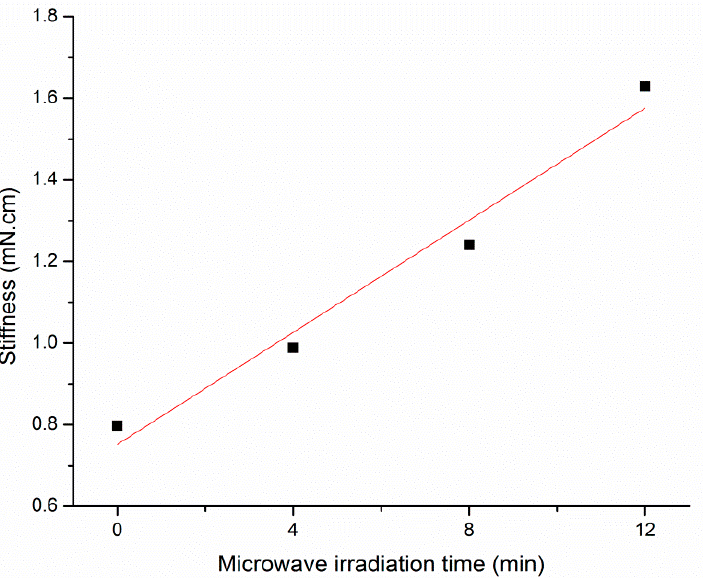
Figure 14. Stiffness of the ZnO-nanorod-coated fabric at different microwave irradiation times.